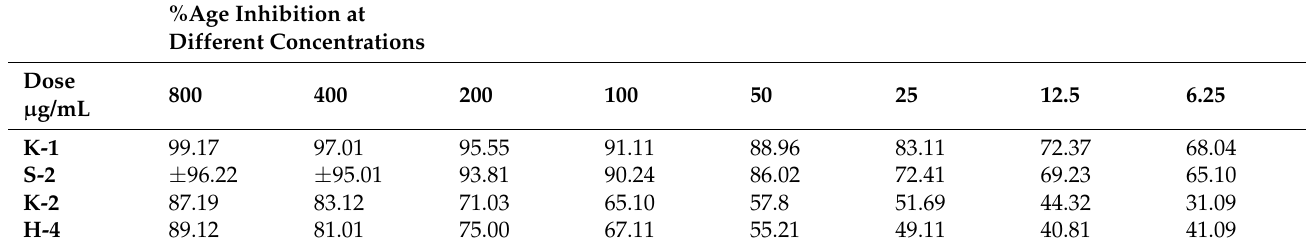
Table 6. Results of alpha glucosidase inhibition